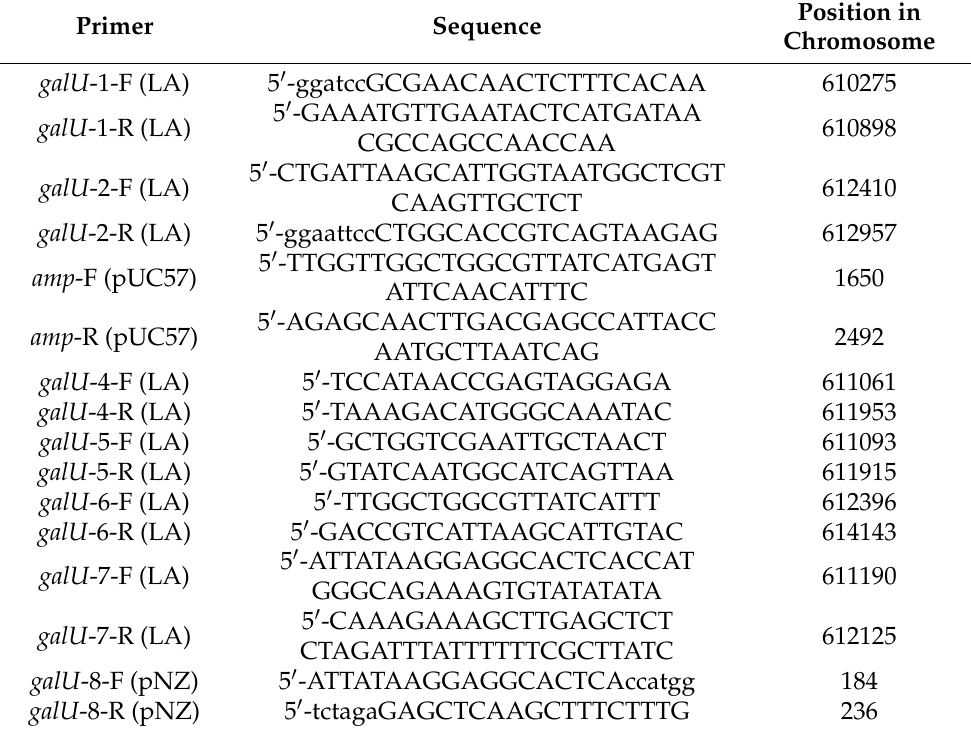
Table 2. The primers used in this